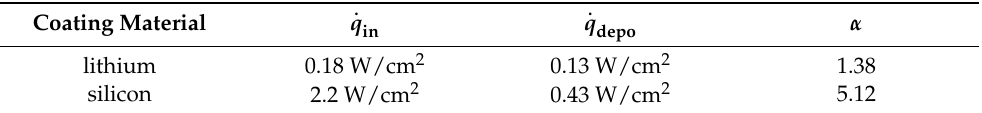
. q , expected heat flux density of deposition in . . q q / at a reference deposition rate of R 0 = 120 nm/s. in depo